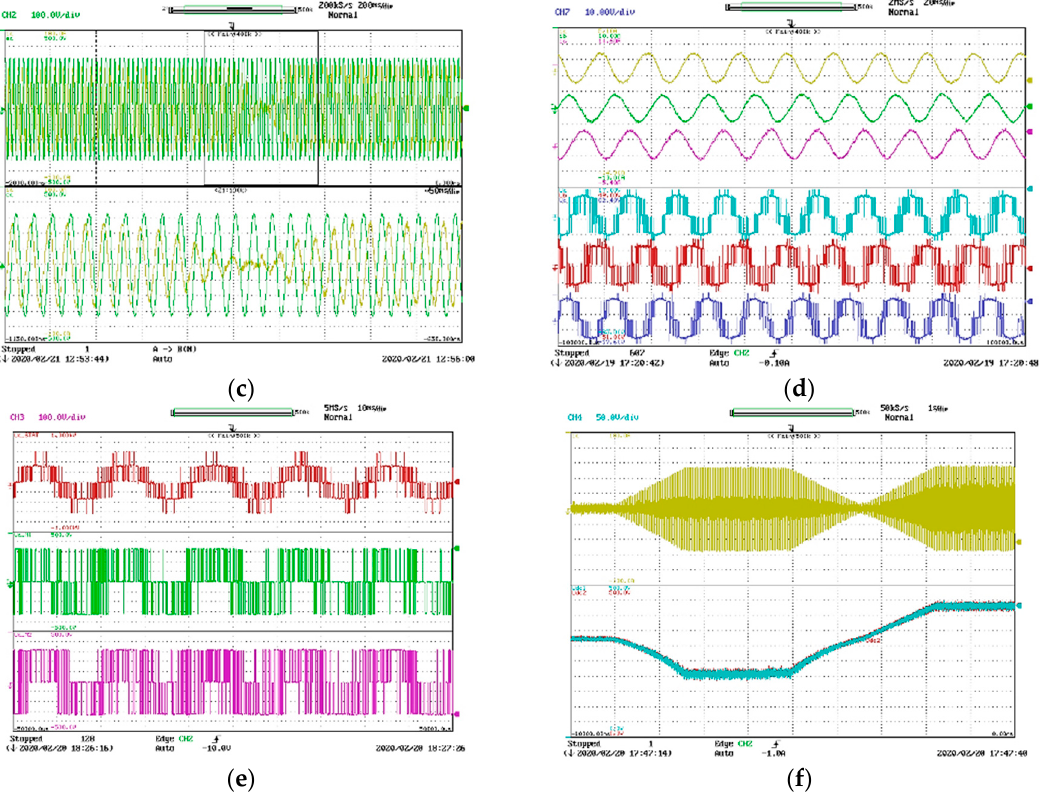
Figure 8. Experimental results: ( a ) three-phase grid currents; ( b ) single-phase grid current; ( c ) single-phase grid current in changing mode; ( d ) grid currents and synthesized STATCOM voltages in the same screen; ( e ) synthesized STATCOM voltage and its voltage per module; ( f ) capacitor DC-link voltages variation.